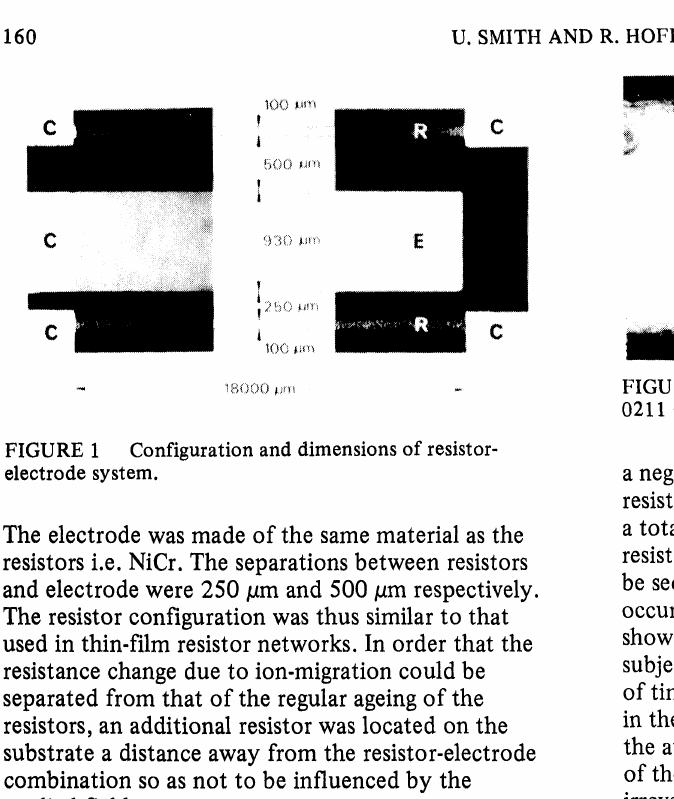
Configuration and dimensions of resistor- electrode system.